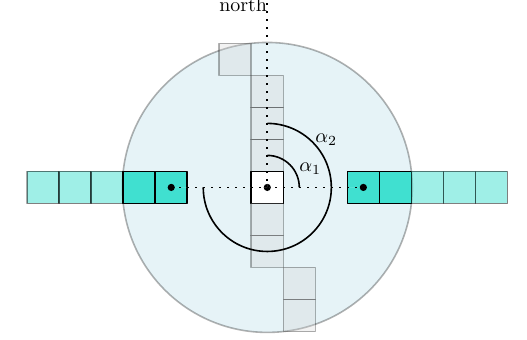
Figure 10. Top view of situation when trajectory passes a doorframe (legend in Fig. 9)